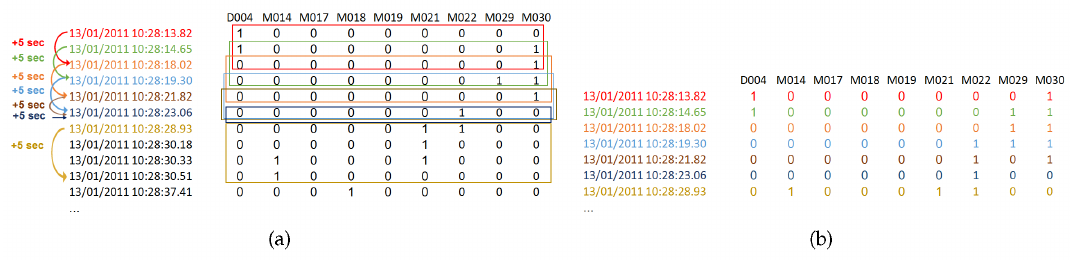
Figure 2. ( a ) Sliding window of size w = 5 s, is run over the multivariate time-series data. ( b ) Transactional